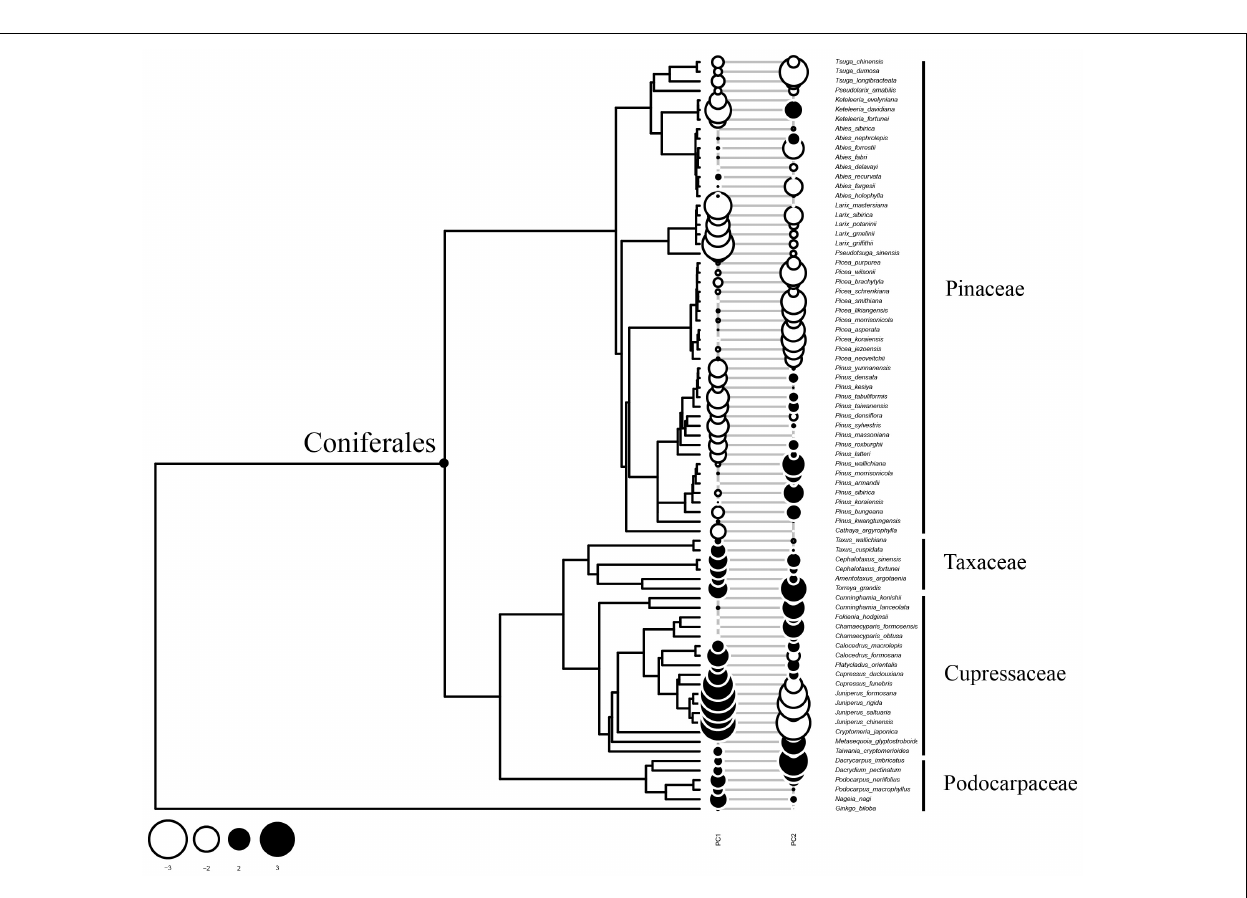
Frontiers in Plant Science |